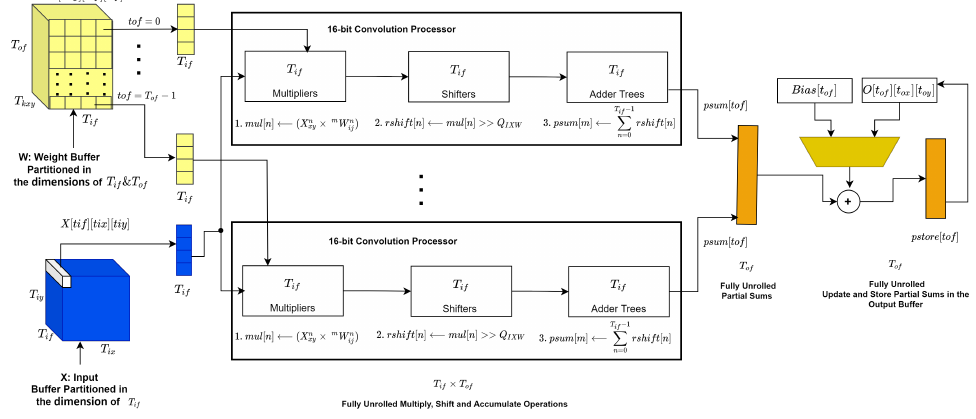
Figure 10. Convolution processor